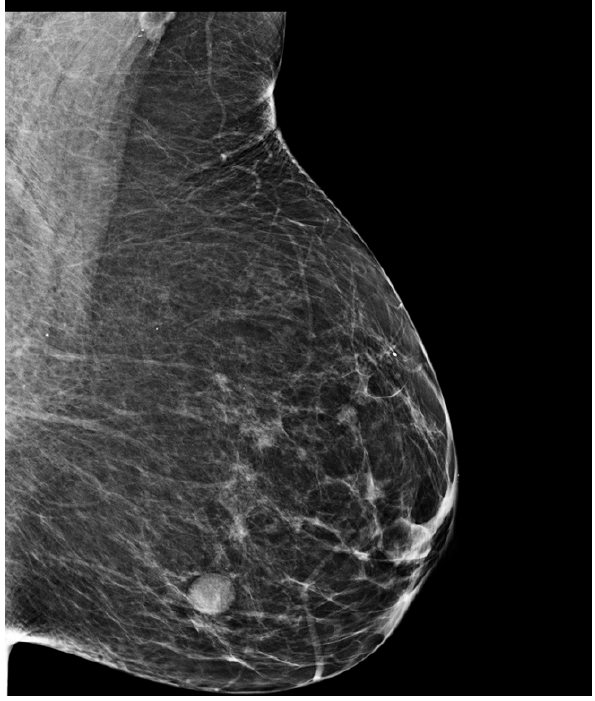
Figure 2. Left breast mammogram—mediolateral oblique incidence.